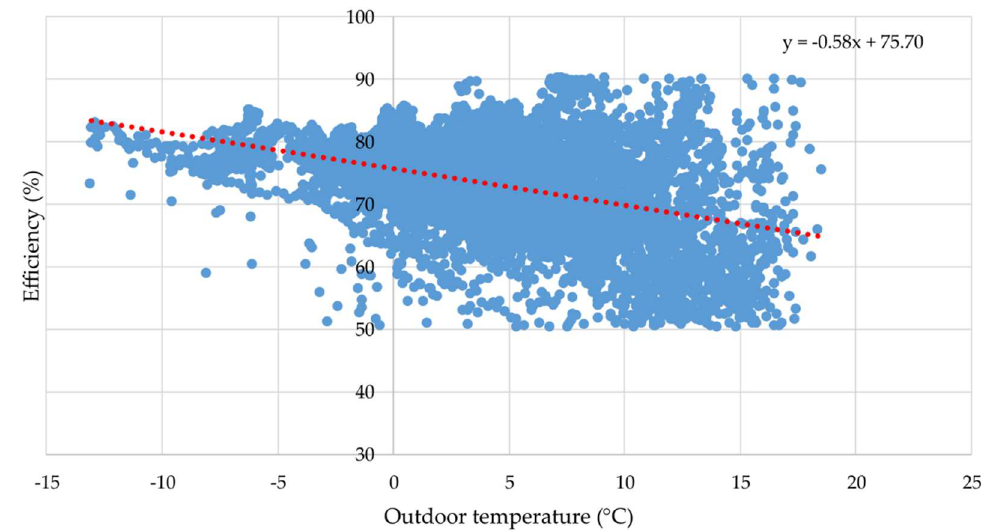
Figure 3. Linear correlation of rotary heat exchanger temperature efficiency in AHU and outdoor temperature; data set 1 September 2014 until 31 May 2015 (sampled every 10 min).